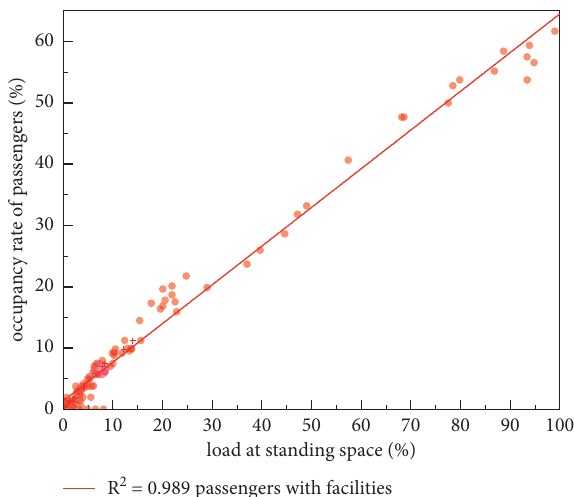
Figure 7: Change of the occupancy rate of passengers with facilities to the load at standing space.